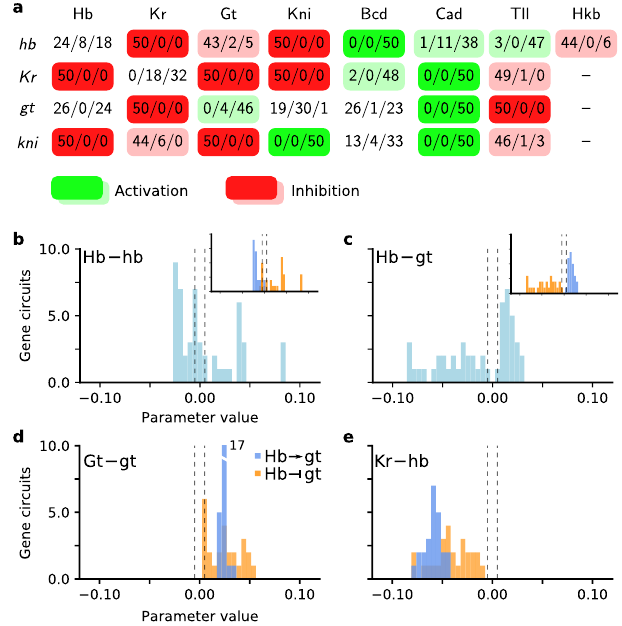
Figure 5. Exploring genetic interactions of the 50 best scatter search circuits. ( a ) Genetic interaction matrix summarizing the type of regulation found amongst the circuits (see also Figure 3). Number triplets define the number of solutions with repressive/no/activating interactions. Columns are regulators, rows target genes. The colour code indicates green for activation and red for repression. Saturated colours indicate full consensus amongst gene circuits, light colours a two-third fraction of circuits for one type of regulation; ( b ) Histogram of parameter values for hb self-regulation. Inset shows the same parameter values split by Hb activating (purple) and inhibiting (orange) gt . See also panel d; ( c ) Histogram of parameter values for Hb regulating gt . The distribution splits into an inhibitory and activating set of gene circuits (see inset); ( d ) Self-regulation of gt split along Hb– gt regulation. Activation ( → ) is purple, inhibition ( (cid:97) ) is orange. The peak of the purple distribution extends to 17 gene circuits; ( e ) Regulation of hb by Kr split along Hb– gt regulation, similar to panel